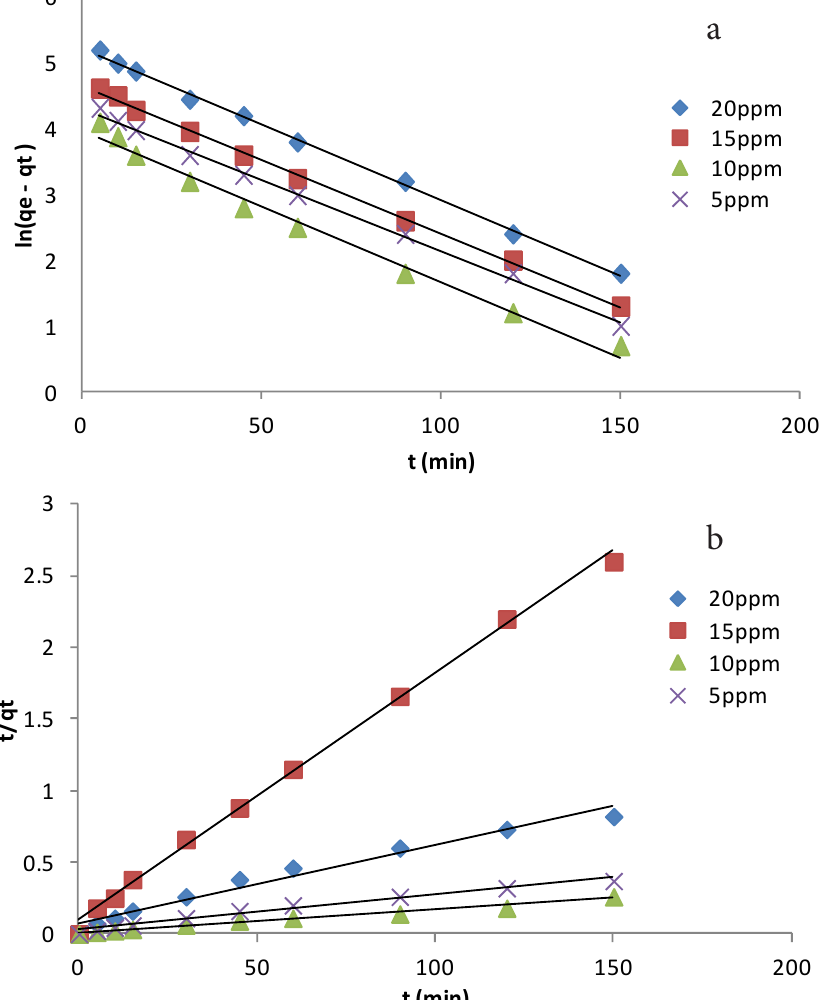
Fig. 8. Pseudo-first-order (a) and pseudo-second-order (b) kinetic plots for the photocatalytic degradeation